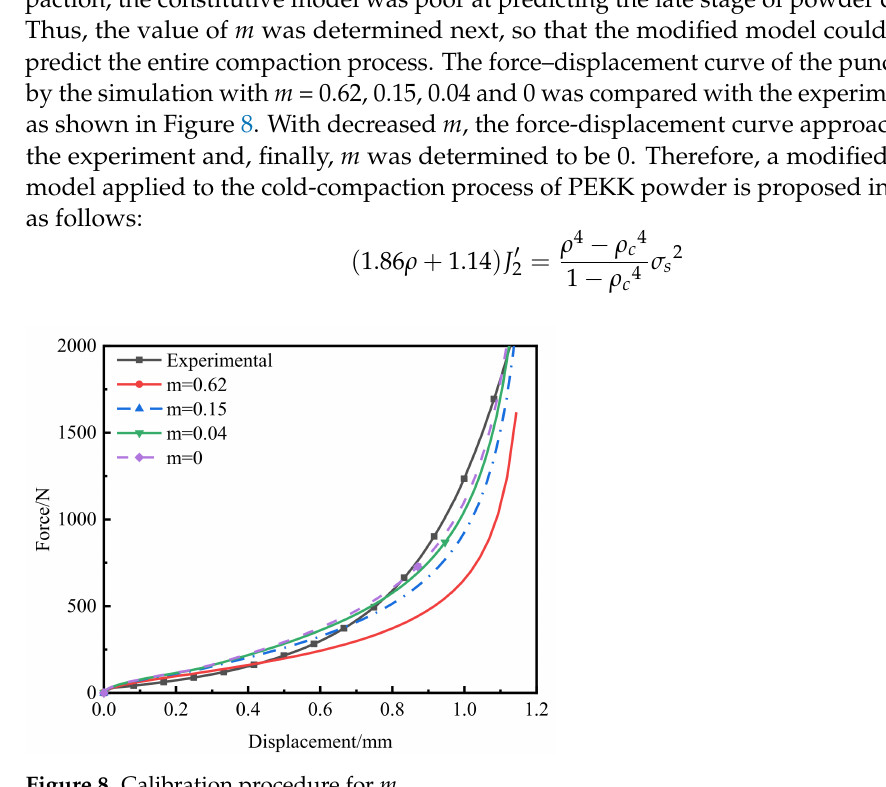
Figure 8. Calibration procedure for m